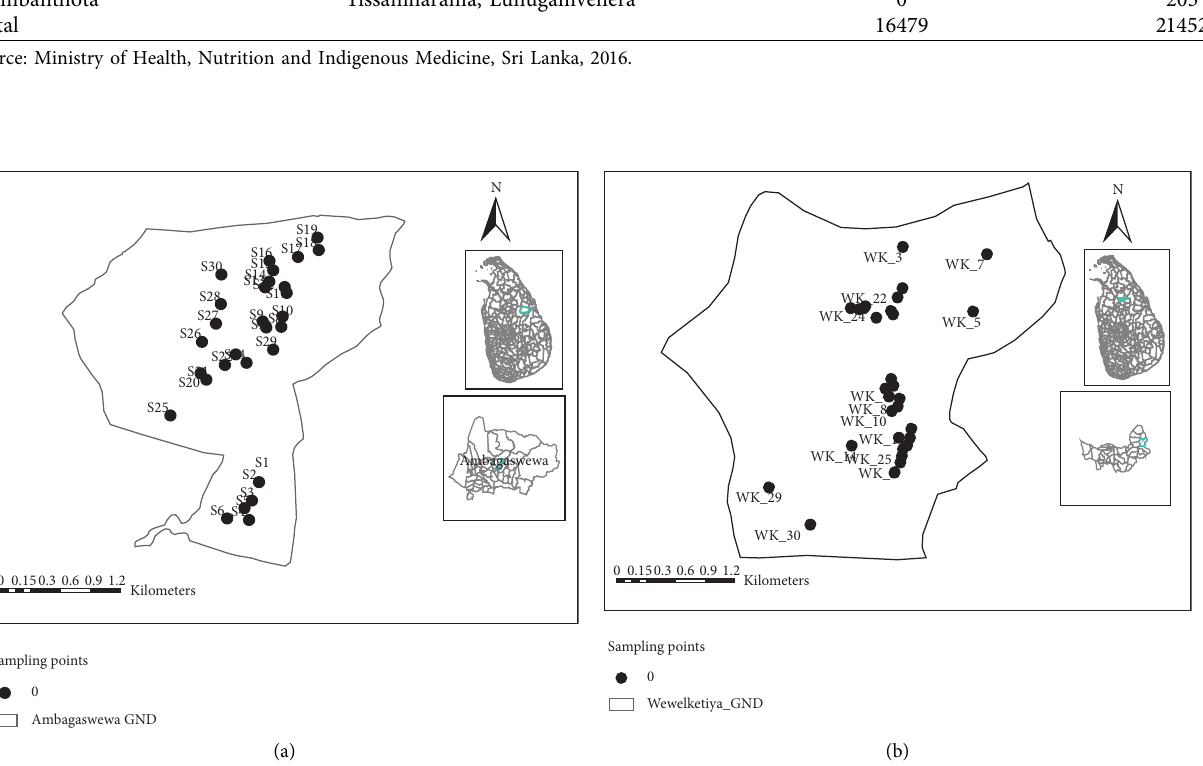
Figure 1: The distribution of sampling points (Aquifer) which were located in the CKDu prevailed areas: (a) Ambagaswewa GND, Madirigiriya DSD, Polonnaruwa District and (b) Wewalketiya GND, Rambewa DSD, Anuradhapura District, Sri Lanka.